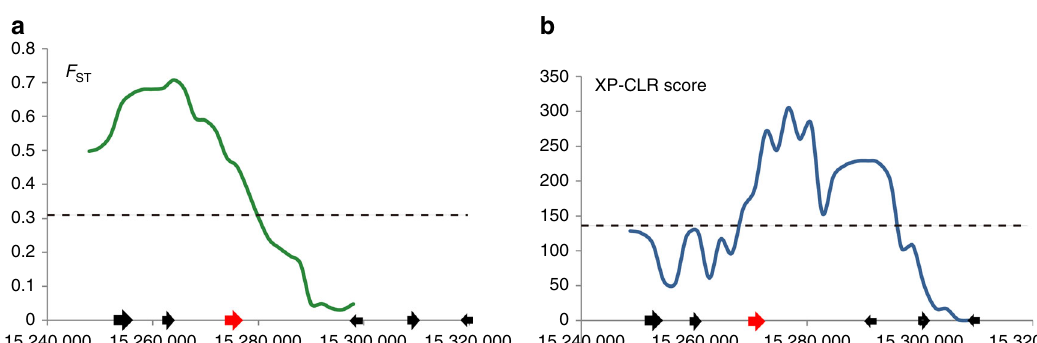
Fig. 1 Arti fi cial selection signal around the OsTb2 region. Peak signals (red arrows) were found by F ST ( a ) and XP-CLR ( b ) assessment, respectively. The arti fi cial selection signals were detected based on the F ST value ( a ) and the cross-population composite likelihood ratio test (XP-CLR, b ). The F ST value and XP-CLR score were calculated window by window (see Methods), and we then choose the windows with genome-wide top 5 ‰ values as candidate regions with selection signals. The dotted horizontal lines indicate the threshold of genome-wide top 5